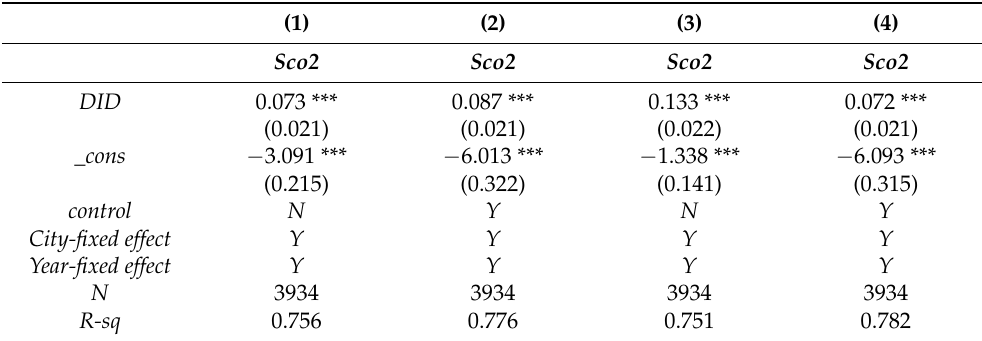
Table 6. We can determine that the coefficients of DID are both significantly positive at the 1% level. Table 6. Adding covariates.